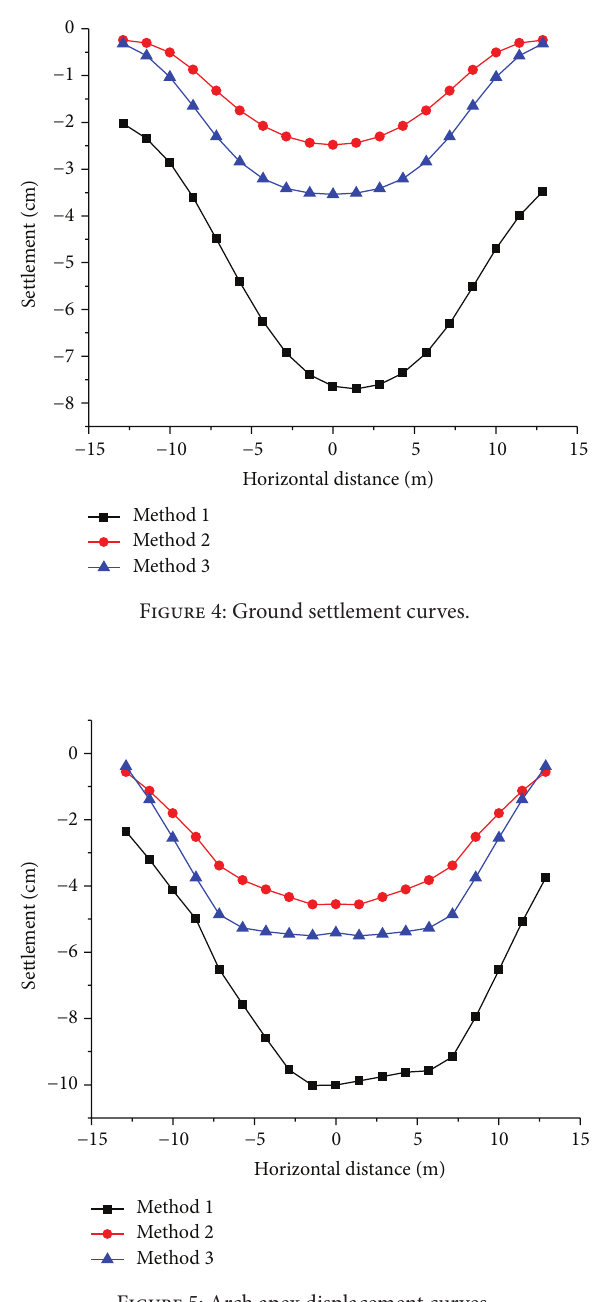
Figure 5: Arch apex displacement